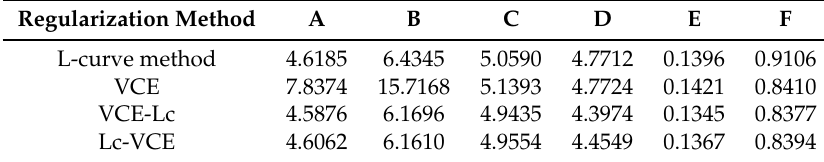
Table 5. RMS values (unit [m 2 /s 2 ]) of each method for different study cases using the Shannon function.